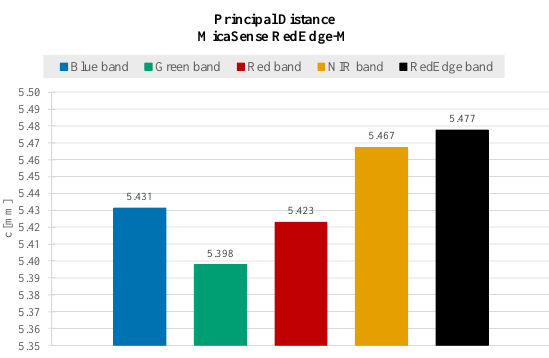
Figure 3: Principal distance for each band Figure 4 shows the different positions of the principal point for the five bands within the individual sensors. The maximum offsets of the principal point from the origin (central pixel) in x is produced by the RedEdge band (85 μm) and by the Green band in y (-83 μm). In general, the values of the principal point coordinates x p and y p might be due to physical manufacturing limits, or the mechanical instability of the camera caused by mechanical stress (rotating the camera and use), as well as temperature changes. The camera is, in fact, prone to overheating after prolonged use.